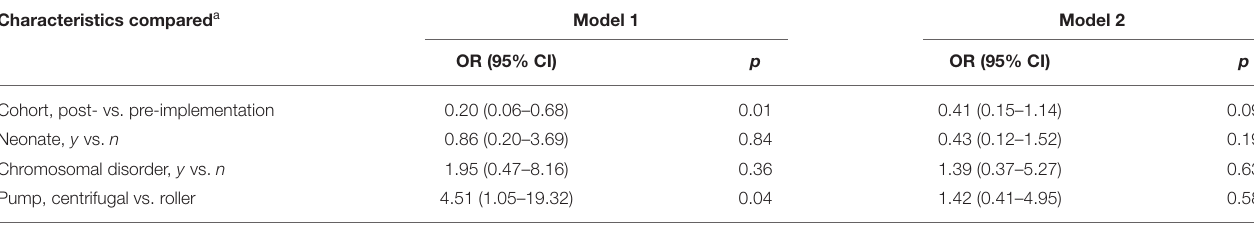
TABLE 4 | Adjusted logistic regression models. Characteristics compared a